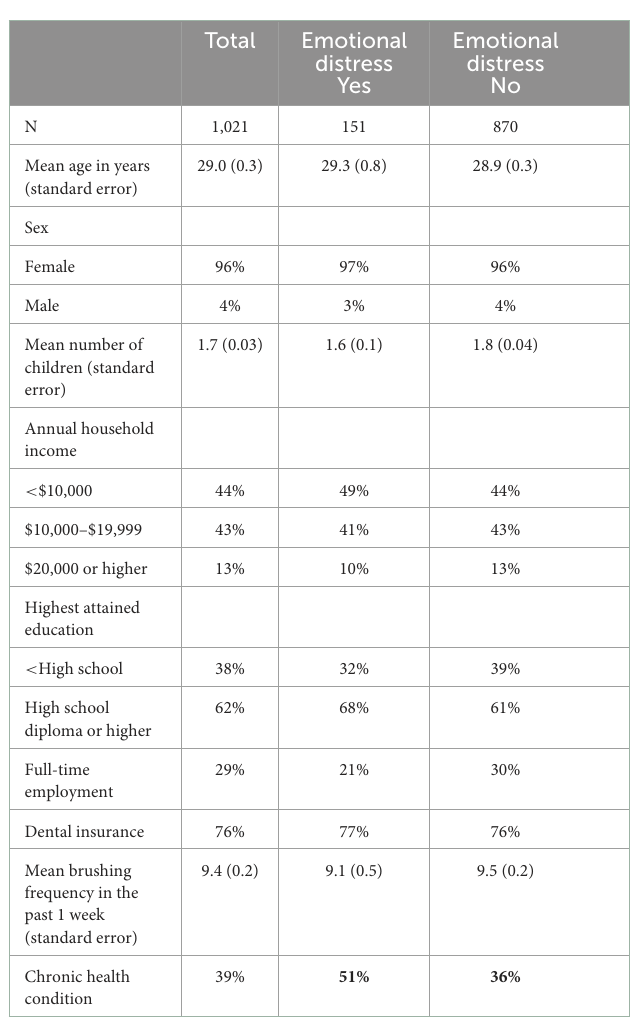
TABLE 1 Selected characteristics of African-American caregivers, Detroit, Michigan,